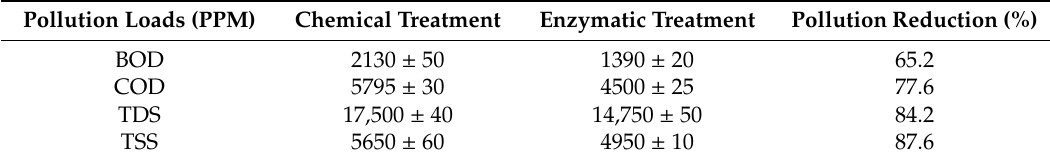
Table 5. Comparison of pollution load generated during cow skin dehairing by chemical processing and treatment with the partially purified protease.